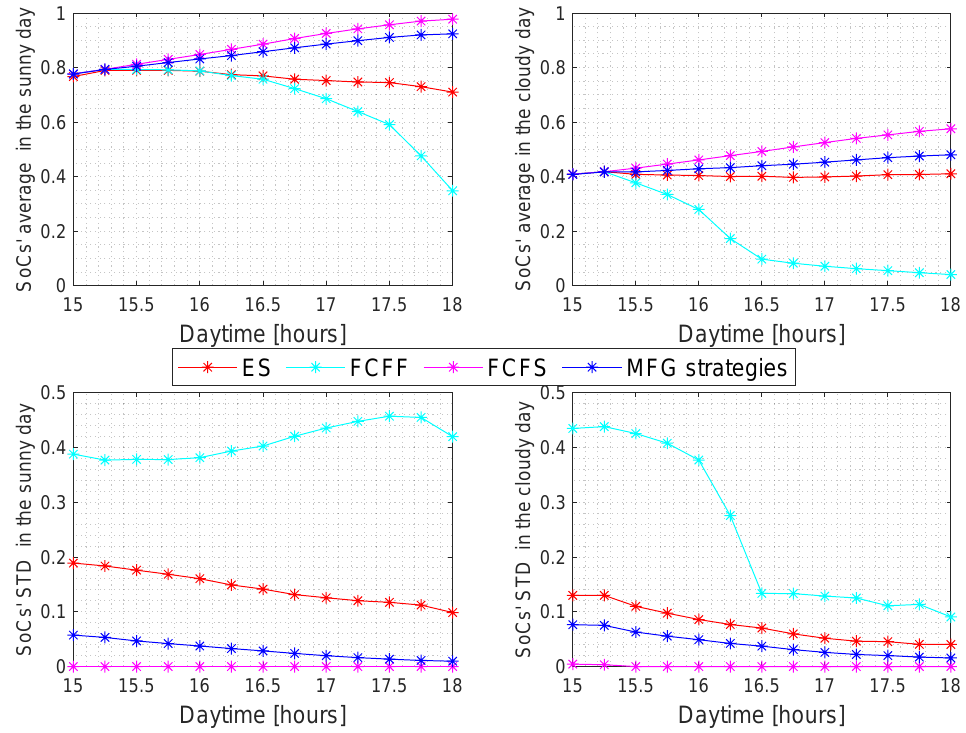
Figure 12. SOCs’ averages and standard deviations of the remaining BEVs in the parking